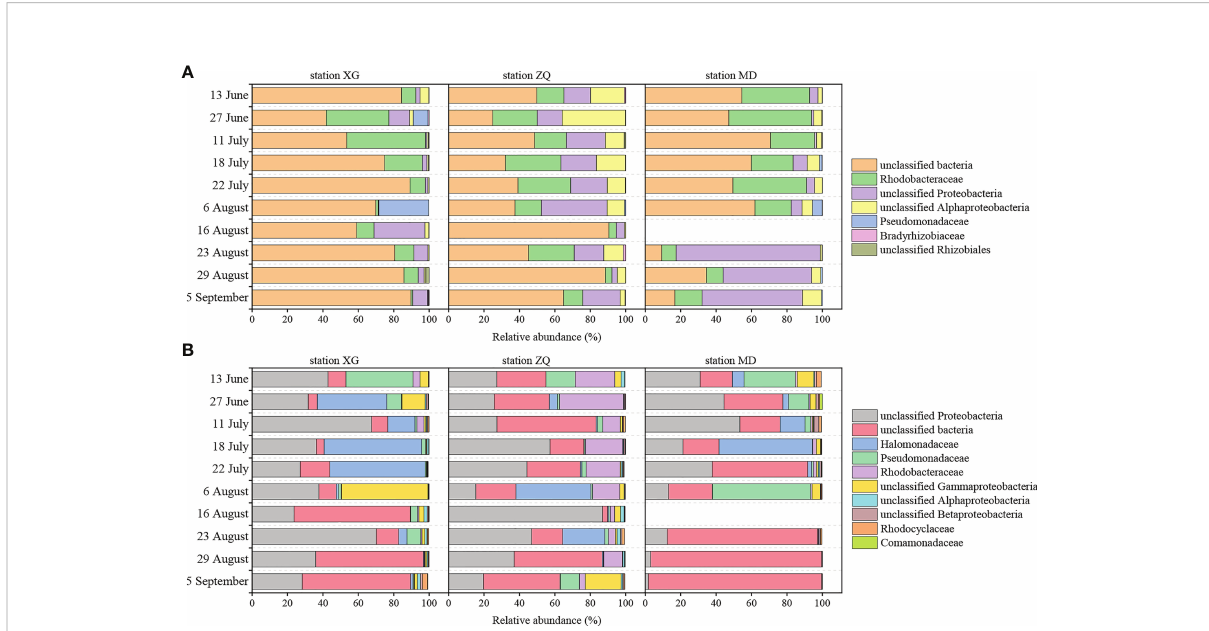
FIGURE 2 Relative abundance of the dominant nirK -type (A) and nirS -type (B) denitrifying bacteria (relative abundance greater than 1%) at the family level during the green tide in coastal Qingdao areas. Due to the failure of the nirK and nirS gene amplicon library construction on 16 August at station MD, the relevant community information was shown as blanks in the